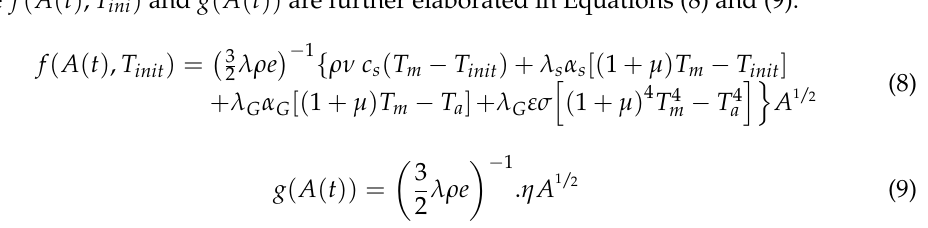
Figure 2. Melt ‐ pool ellipsoidal volume. A is the melt pool cross ‐ sectional area. As represents the melt pool surface area where convection is taking place. A G represents the melt pool surface area in contact with solid metal.